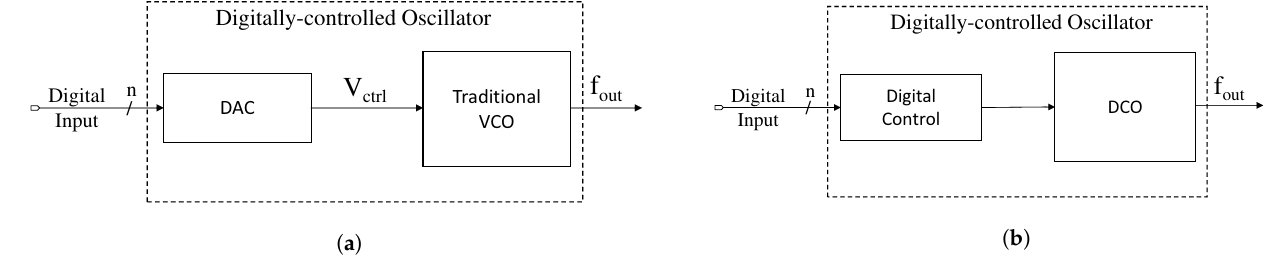
Figure 1. DCO controlled by ( a ) DAC, and by a ( b ) digital controller.